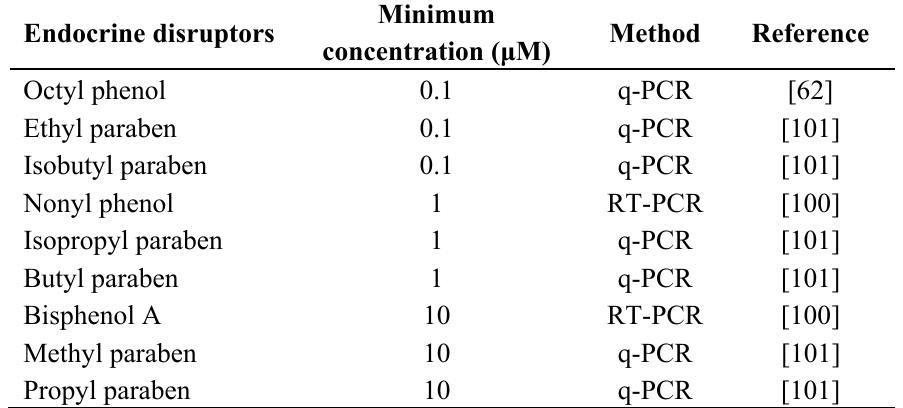
Table 3. Expression of CaBP-9k on in vitro system under different EDs